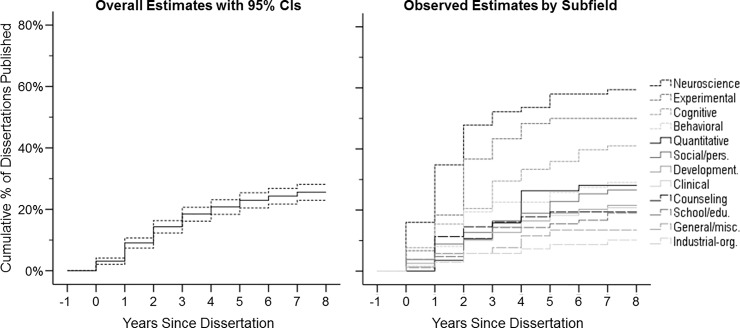
Estimated cumulative rates of dissertation publication over time.Overall estimates and 95% confidence intervals (left panel) are derived from the weighted Cox regression model (see Table 3). Subfield estimates (right panel) are derived from the unweighted Kaplan-Meier regression model. In both plots, cumulative publication estimate = one minus survival function.